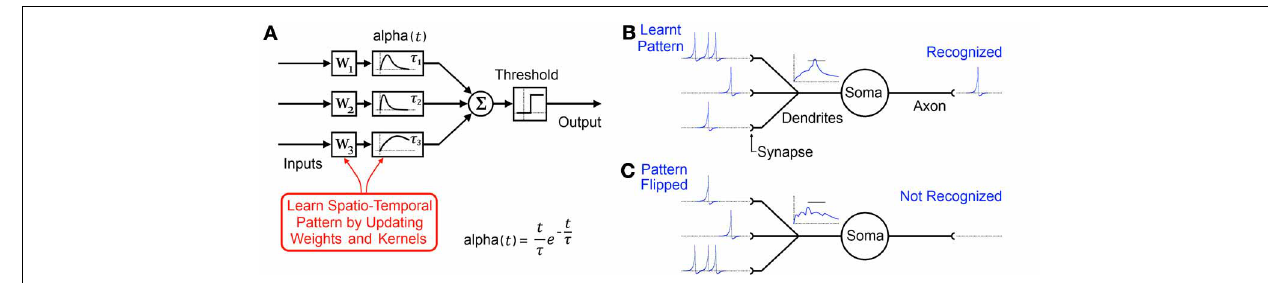
FIGURE 2 | (A) Typical model of a single element in a distributed temporal coding memory network with synaptic alpha functions used as decaying synaptic kernels producing a decaying memory of recent spikes. (B) Biological representation of the same element. Through